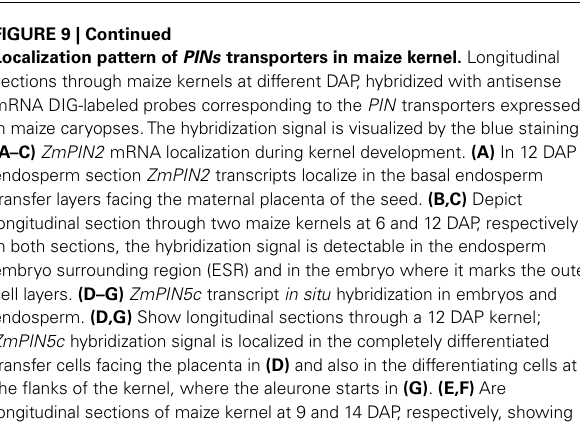
FIGURE 9 | Continued Localization pattern of PINs transporters in maize kernel. Longitudinal sections through maize kernels at different DAP, hybridized with antisense mRNA DIG-labeled probes corresponding to the PIN transporters expressed in maize caryopses.The hybridization signal is visualized by the blue staining. (A–C) ZmPIN2 mRNA localization during kernel development. (A) In 12 DAP endosperm section ZmPIN2 transcripts localize in the basal endosperm transfer layers facing the maternal placenta of the seed. (B,C) Depict longitudinal section through two maize kernels at 6 and 12 DAP, respectively: in both sections, the hybridization signal is detectable in the endosperm embryo surrounding region (ESR) and in the embryo where it marks the outer cell layers. (D–G) ZmPIN5c transcript in situ hybridization in embryos and endosperm. (D,G) Show longitudinal sections through a 12 DAP kernel; ZmPIN5c hybridization signal is localized in the completely differentiated transfer cells facing the placenta in (D) and also in the differentiating cells at the flanks of the kernel, where the aleurone starts in (G) . (E,F) Are longitudinal sections of maize kernel at 9 and 14 DAP, respectively, showing